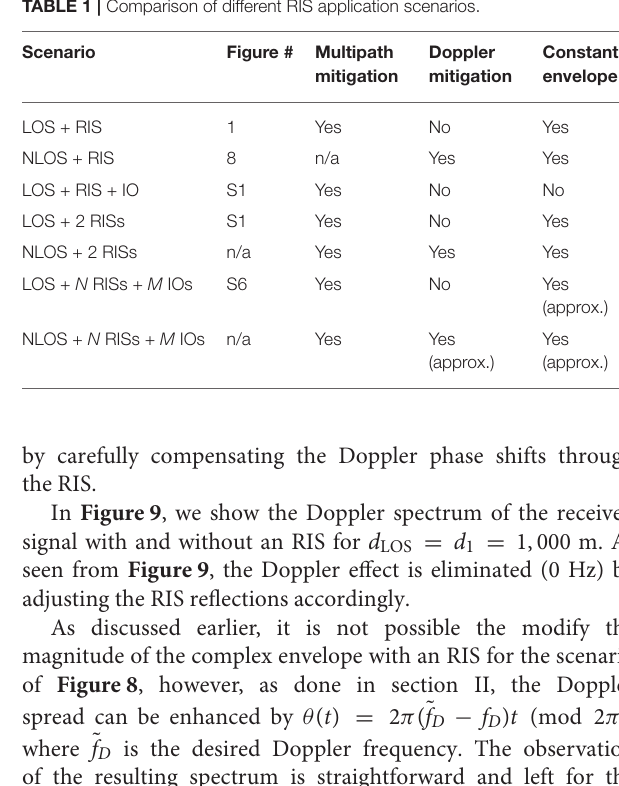
Doppler Constant mitigation mitigation